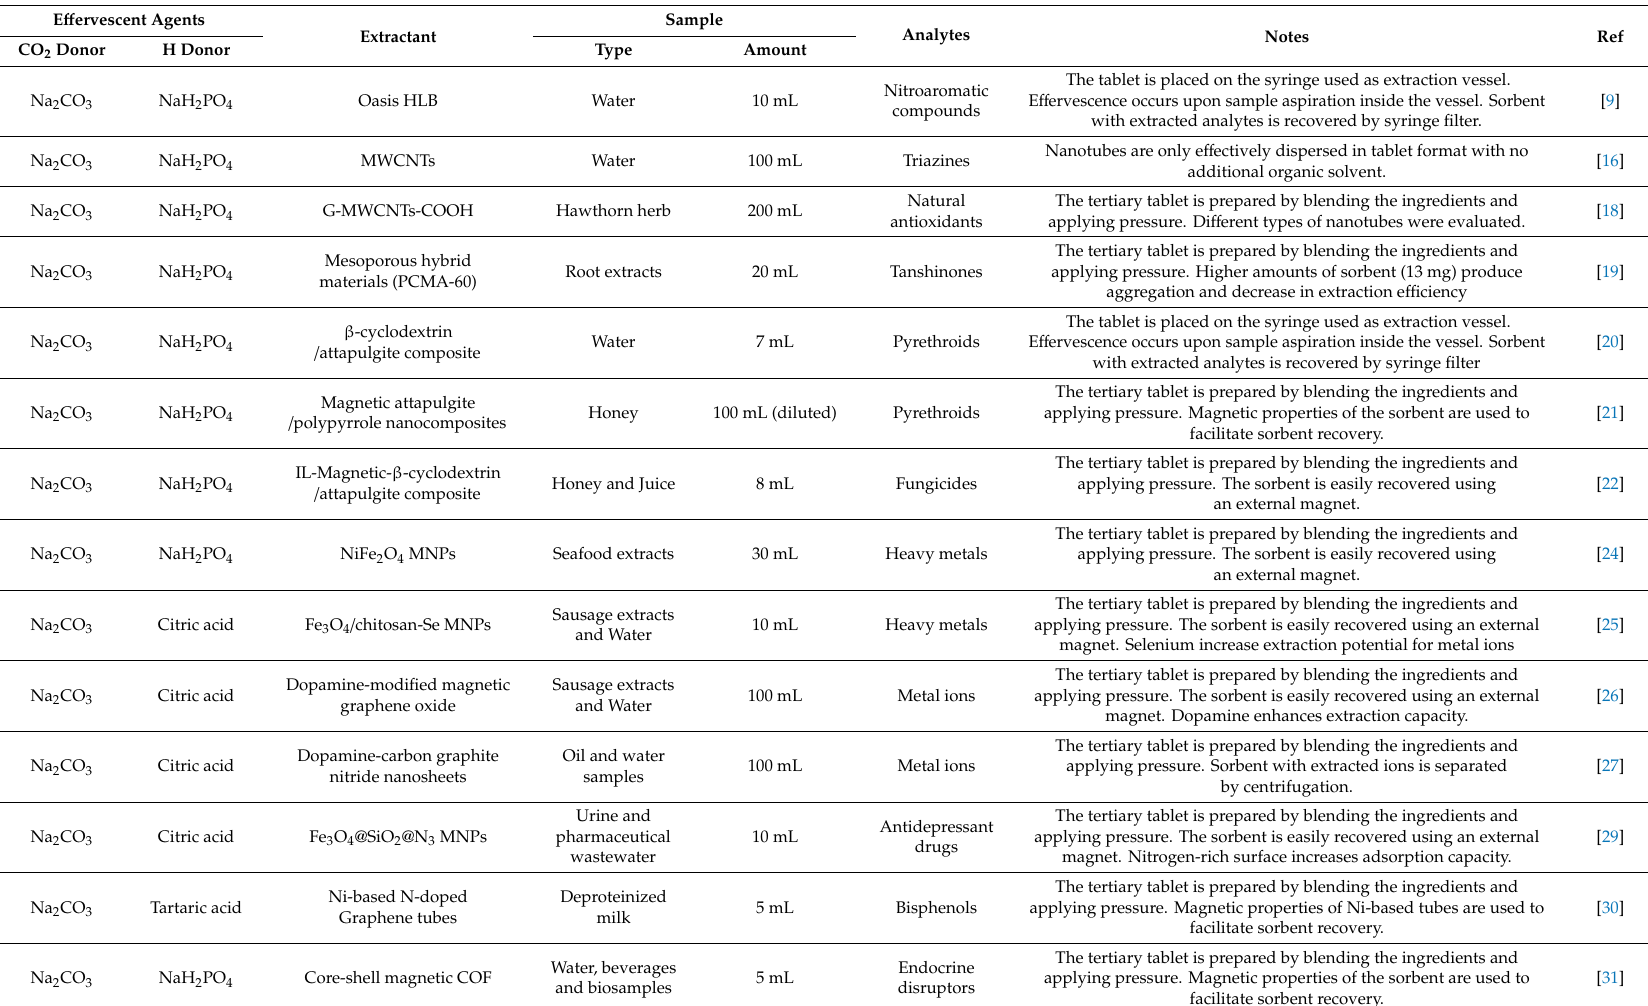
Table 1. Selected applications based on the use of e ff ervescence-assisted